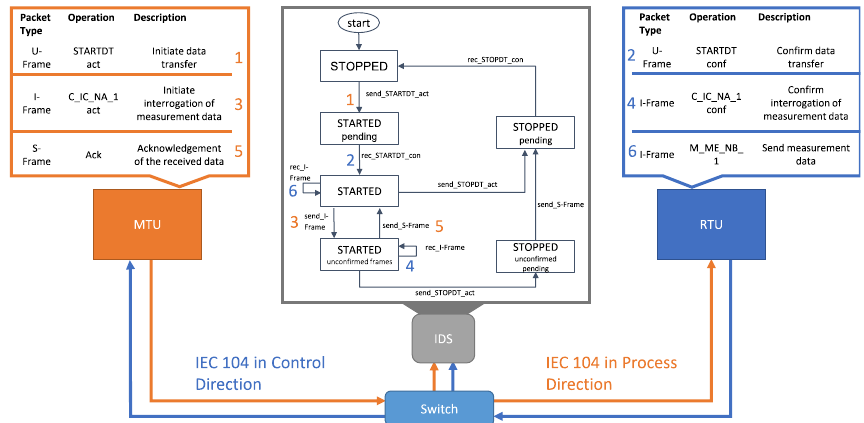
Fig. 5 Example illustration of packet flow conformance checking based on the MTU automaton model, showing a simple MTU and RTU communication scenario